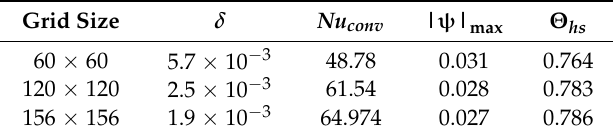
Table 3. Grid independence study for Ra = 10 9 , (cid:101) (cid:101) = 0, τ =